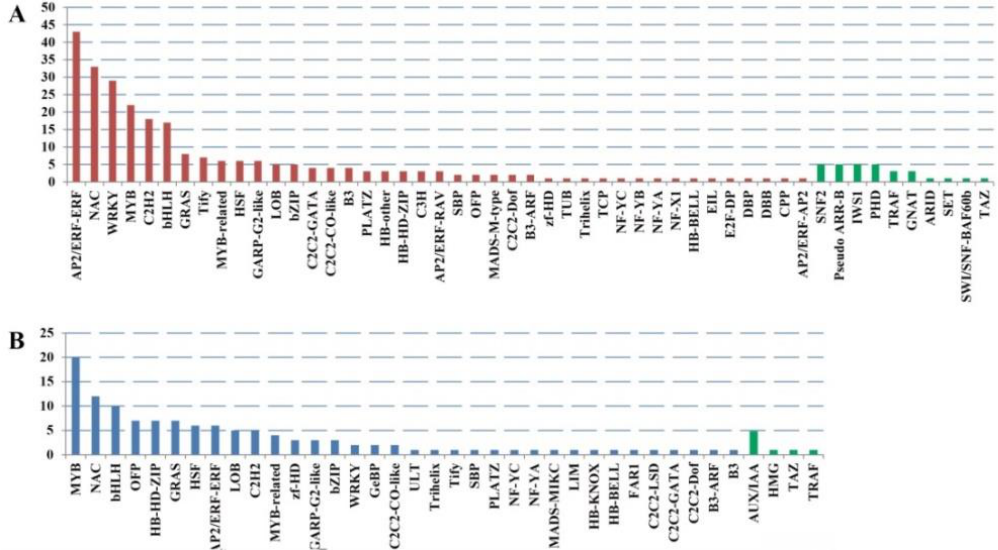
Figure 3. The transcription factors (TFs) and transcriptional regulators (TRs) classification of DEGs by iTAK software. ( A ) The classification results of the TFs and TRs of the up-regulated DEGs. Red bars represent TFs, and green bars represent TRs. ( B ) The classification results of the TFs and TRs of the down-regulated DEGs. Blue bars represent TFs, and green bars represent TRs.